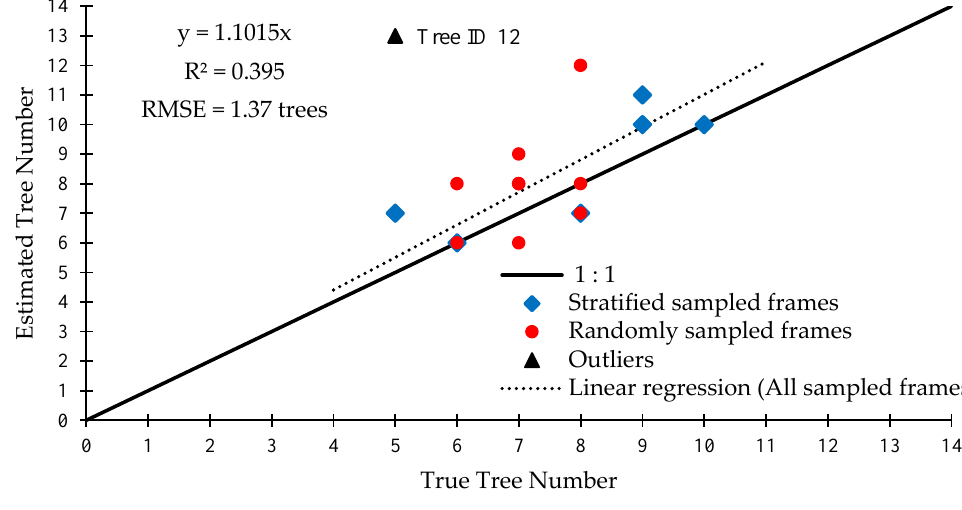
Figure 9. True tree count vs. estimated tree count per frame.